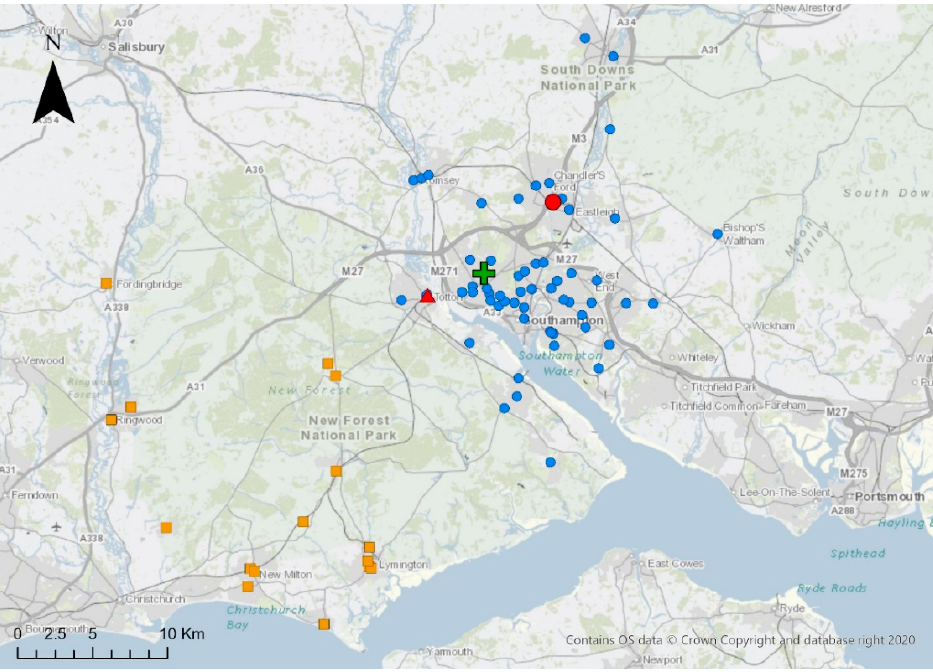
Figure 9. Map showing locations of rural GP surgeries and alternative PTS vehicle depot. Red circle shows the location of Eastleigh PTS depot, red triangle shows the location of possible alternative PTS depot (Totton), blue circles and orange squares show the locations of GP surgeries (orange squares identify more rural surgeries) and green cross shows the location of SGH.